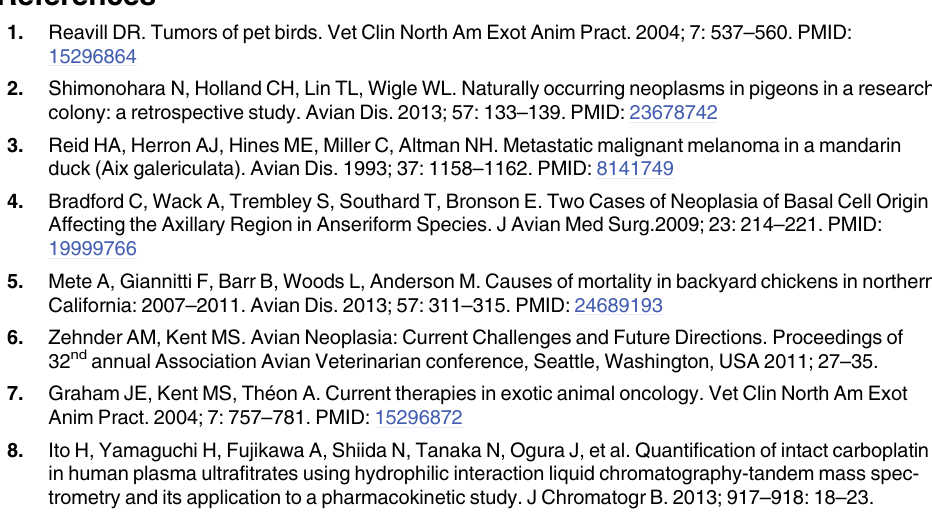
S1 Table. Results of the evaluation of linearity (goodness-of-fit (g) and correlation coeffi- cient (r)) and limit of quantification (LOQ) for quantification of free carboplatin in plasma of chickens, ducks, pigeons and parakeets. S2 Table. Results of the within-run and between-run accuracy and precision for quantifica- tion of free carboplatin in plasma of chickens, ducks, pigeons and